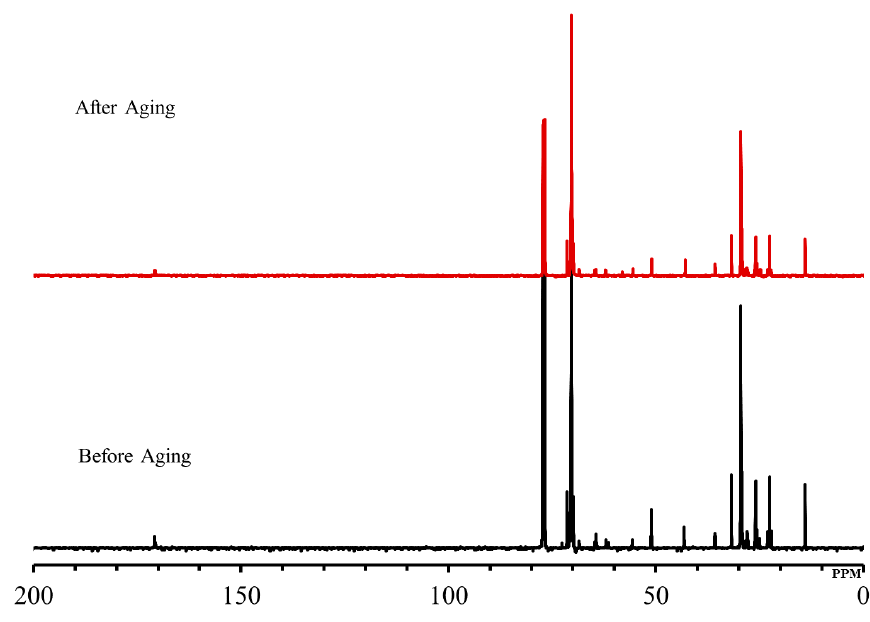
Figure 8. 13 C NMR of GS10 sample before aging and after aging.